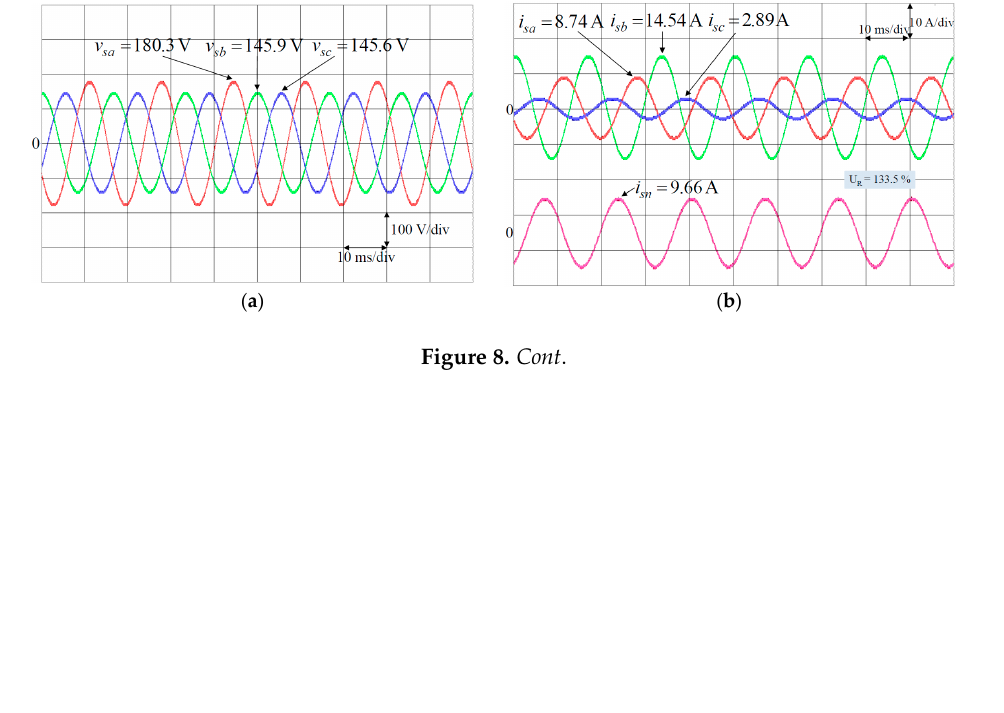
Figure 7. Experimental results at unbalanced load 3: ( a ) Responses of three-phase currents i sa , i sb , i sc